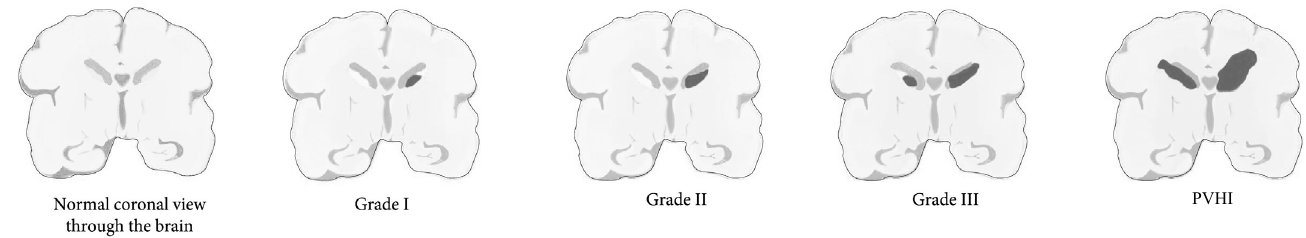
Figure 1. Schematically representation of IVH classification by Volpe. Figure legend: PVHI (periventricular hemorrhagic infarction).